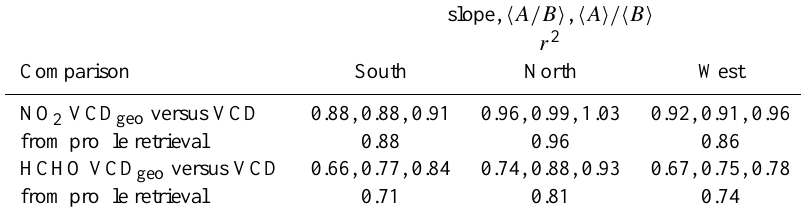
Table 6. Comparison results of geometric trace gas VCDs (using 18 ◦ and 90 ◦ elevation angles) versus VCDs from the MAX-DOAS profile retrieval for clear sky observations from 12 to 26 September, see text). Besides the slopes of the fitted regression line, the mean value of the individual ratios h A/B i the ratio of the mean values h A i / h B i (see Eqs. 20 and 21) and the coefficient of determination, r 2 , are